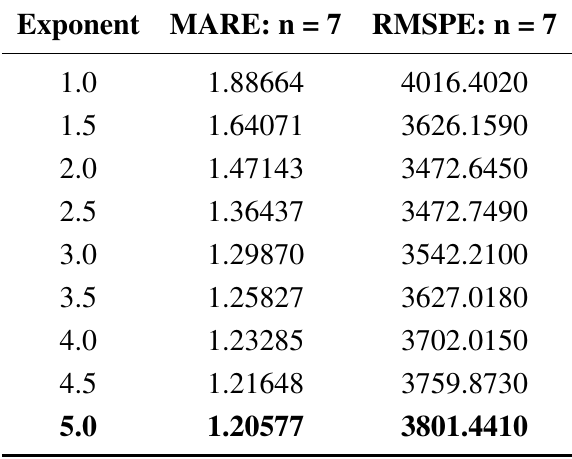
Table 4. MARE and RMSPE results for nine IDW methods with a maximum of seven nearest neighbors using the improved IDW